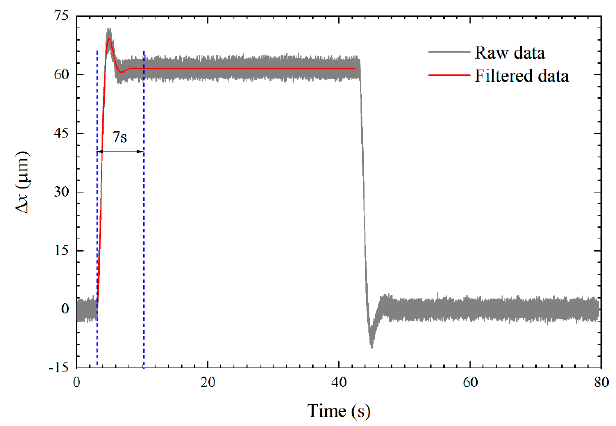
Figure 10. Dynamic response to a step force.